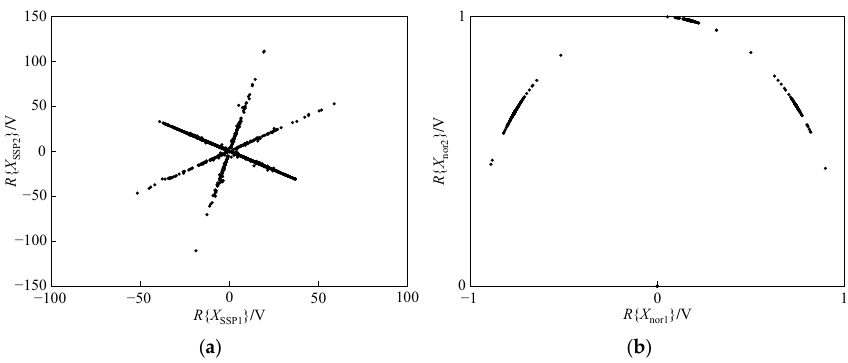
Figure 7. Scatter diagram of the real part of the SSPs and normalized data; (( a ): the real part of the SSPs; ( b ): the real part of the normalized data.).